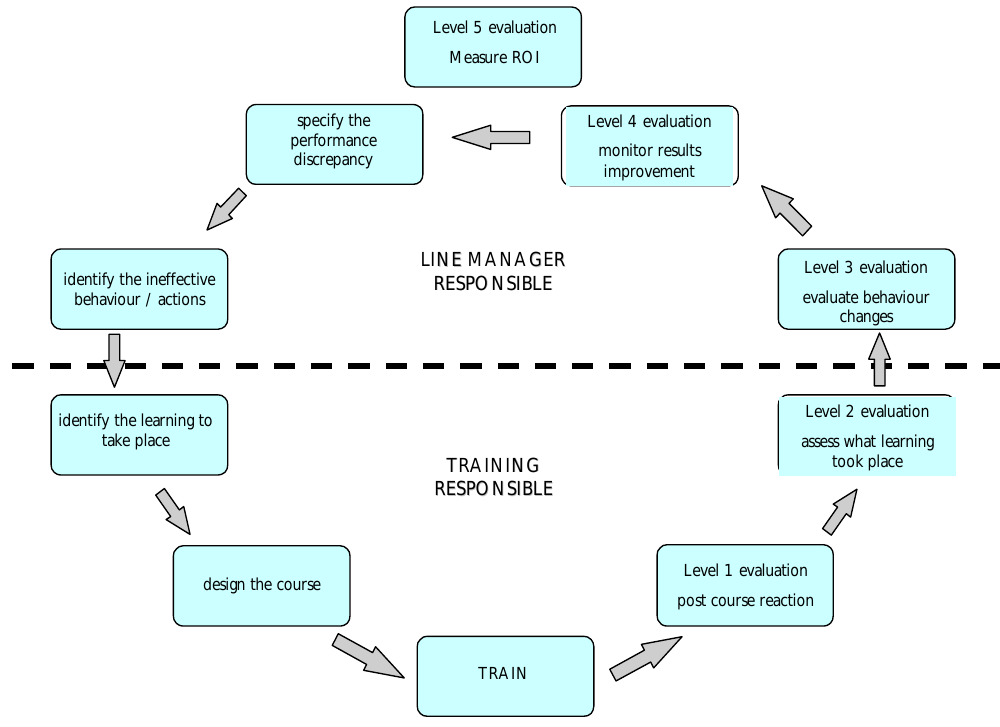
Figure 1: Donald Kirkpatrick’s evaluation hierarchy with Phillips’ fifth level inserted Sources: Kirkpatrick, 1979, 1996; Phillips 1996,